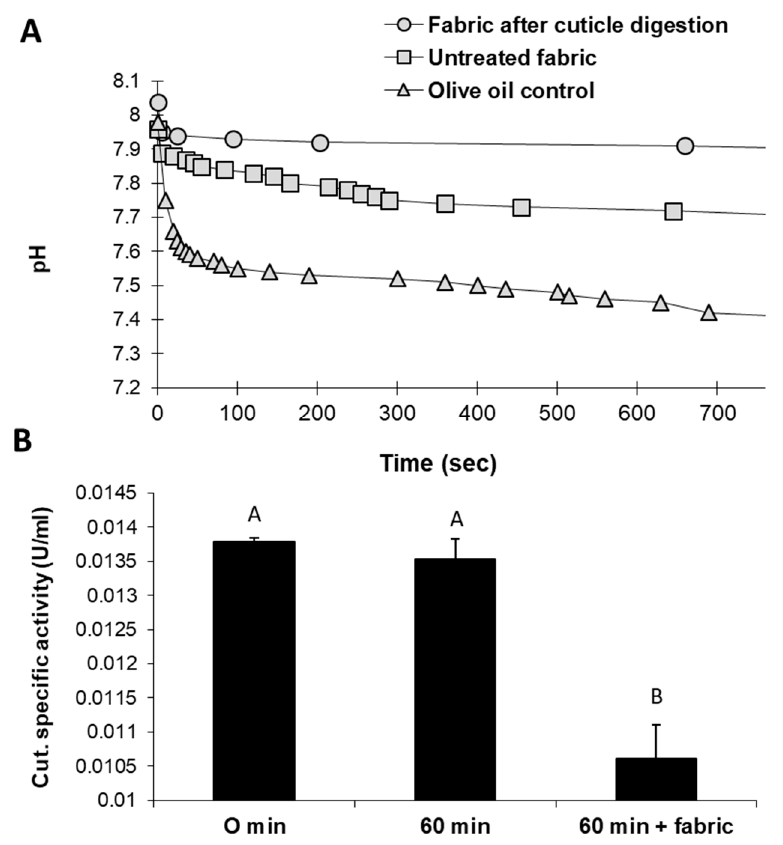
Figure 2. Cutinase activity with raw cotton fabrics. ( A ). Lipase assay—pH drop as a result of cutinase activity with raw cotton fabrics (without any pretreatment). Olive oil, 1.4 mL, served as a positive control, while 1 gr cotton fabrics after chemical scouring (done as described in Figure 1) was a negative control. All fabrics were incubated with 0.04 U/mL cutinase in a 5 mL mixture containing 20 mM buffer potassium phosphate, pH 8 and 0.04% Triton ® X-100. The reactions were performed at room temperature (ca. 25 ◦ C). The experiment was repeated three times and the results were similar. ( B ). Cutinase (Cut.) specific activity after 60 min incubation with raw untreated 1 gr cotton fabrics. Controls are the initial cutinase activity (0 min) and cutinase specific activity after 60 min incubation under the same conditions without the substrate—raw cotton fabrics (60 min). The reaction mixture is as described above. Incubation was performed by placing the test tubes diagonally in a rotary shaker and rotating them at 175 rpm and 37 ◦ C. Values are an average of at least three independent replicates. Error bars represent a standard error. Levels not connected by the same letter (A, B) are significantly different ( p < 0.05, ANOVA). Table 1. GC-MS identification of the main components of waxes extracted from raw cotton fabrics (reflux in hot DCM overnight).